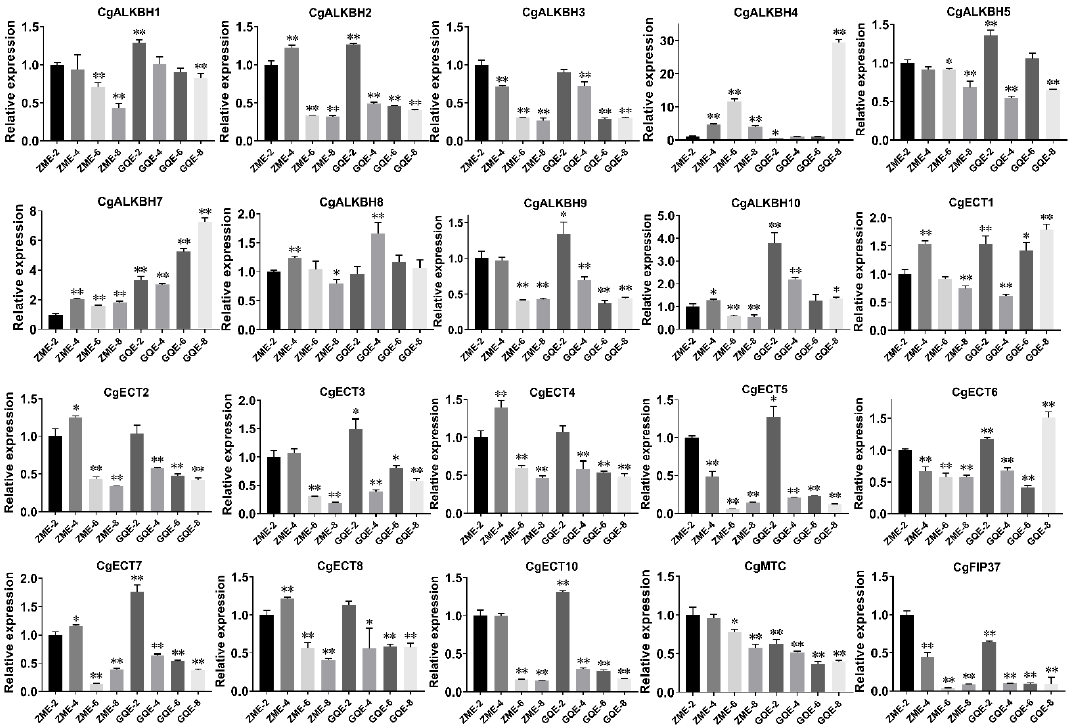
Figure 6. Relative expression of 20 m 6 A regulatory genes in the fruits of ZM and GQ during various growth points. Actin was used for the qRT-PCR data normalization. The name of the genes is indicated above each bar diagram. Error bars indicate the standard deviation, Student’s t -test was used for statistical analysis; * p < 0.05, ** p < 0.01. (ZM and GQ are the names of the two varieties, the first number followed with ZM or GQ stands for the diameter of the fruits and the last number represents the biological